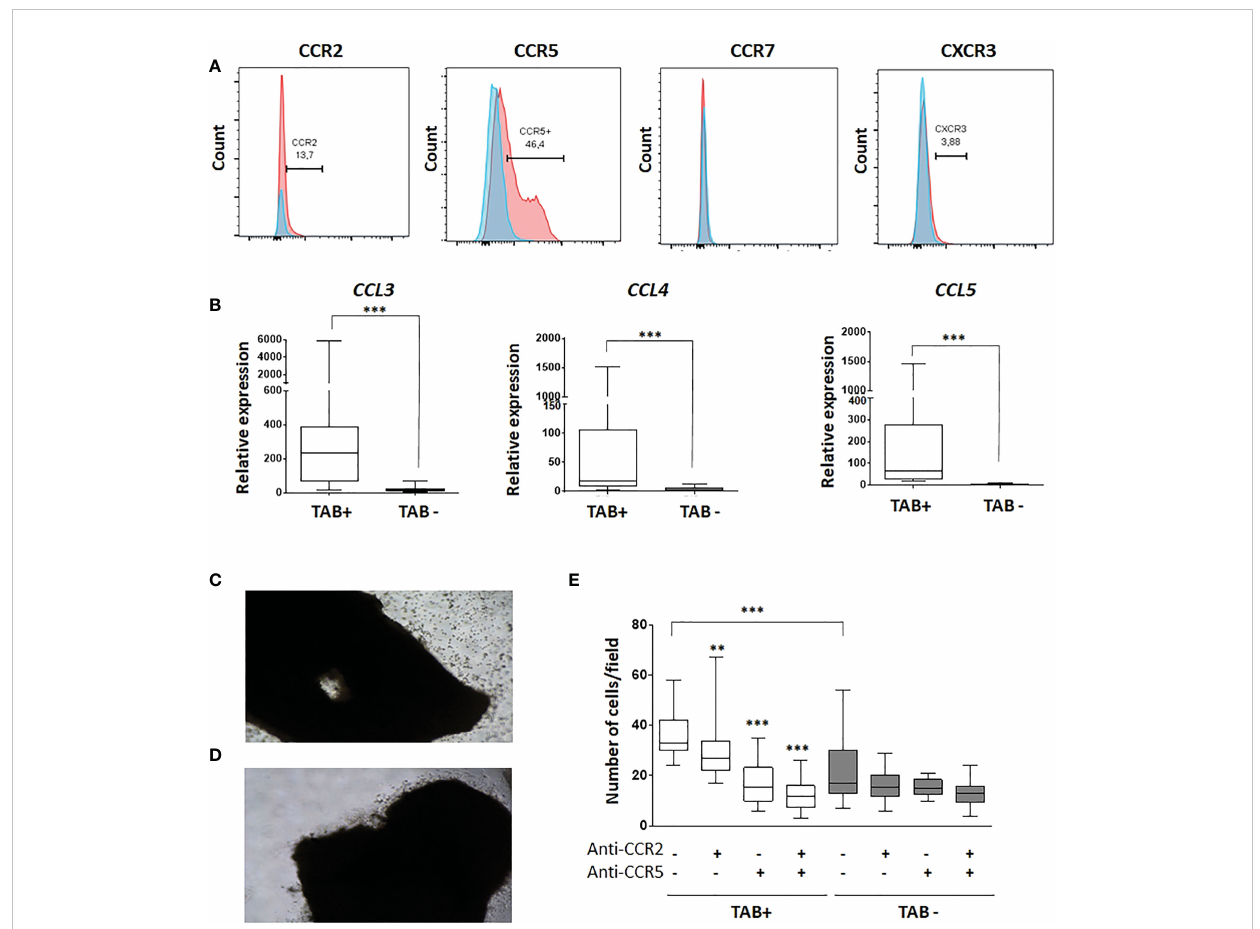
FIGURE 6 Recruitment of HuMoSC in GCA arteries implicates an interaction between CCR5 and its ligands. (A) representative fl ow cytometry analysis of HuMoSC. Blue histogram is the isotype control and red histograms are staining of HuMoSC after CD14 gating (representative of 10 independent experiments). (B) mRNA expressions of CCL3 , CCL4 and CCL5 in positive TAB (n=12) and negative TAB (n=9) after 5 days of ex vivo culture in MATRIGEL ® . (C, D) Picture of a representative positive TAB after 4 hours of culture in MATRIGEL with (C) or without (D) HuMoSC. (E) Migration assay in Boyden chamber. The lower chamber was fi lled with supernatants of negative or positive TABs cultivated in MATRIGEL during 5 days. A total of 30.10 3 HuMoSC were added in the upper chamber with or without antagonist of CCR2 (calbiochem, 100 nM) and/or CCR5 (maraviroc, 1 µM). After 4.5-hour incubation, the polycarbonate membrane was stained with hematoxylin and eosin and washed before counting number of cells/ fi eld. Each condition was performed in quadruplet and 2 fi elds were analyzed per condition. The experiment was repeated 3 times independently. For statistical analyses, each condition was compared with the condition in which there was no treatment with antagonists of CCR2 and CCR5, except otherwise speci fi ed. Statistics: Whisker boxes show median (horizontal bar), IQR (limits of the box) and extreme values (error bars). P is the result of Mann Whitney test (untreated TAB+ vs. untreated TAB-) or Wilcoxon tests (untreated TAB + vs . TAB+ treated with anti-CCR2, anti-CCR5 or both): **P < 0.01; ***P < 0.001